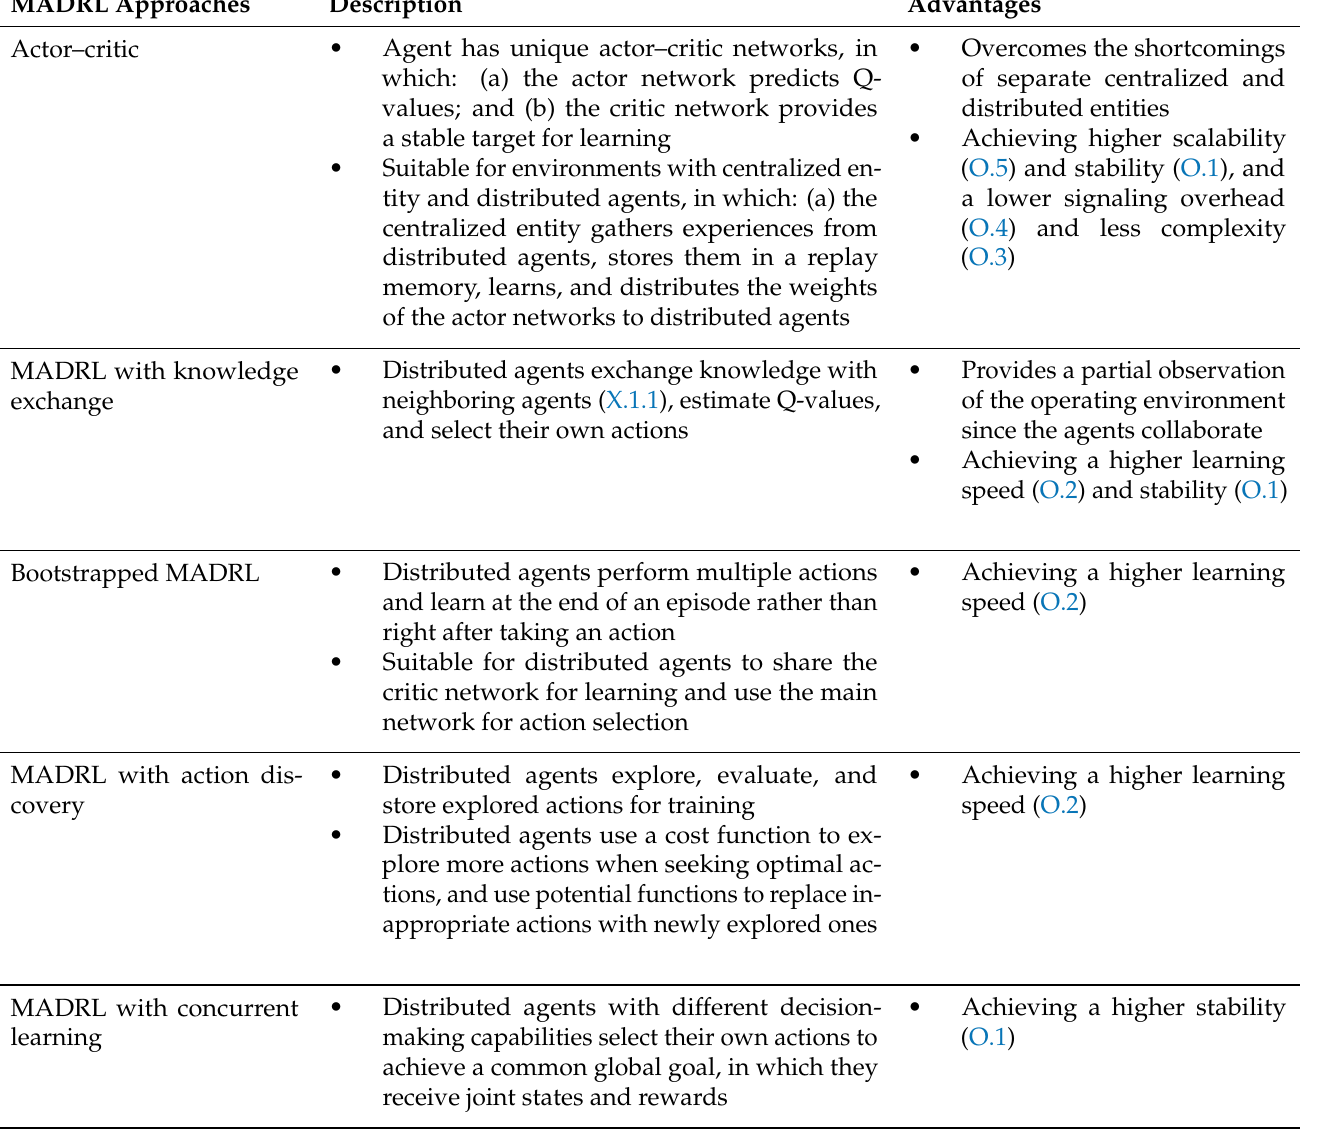
Table 5. Summary of MADRL extensions and their